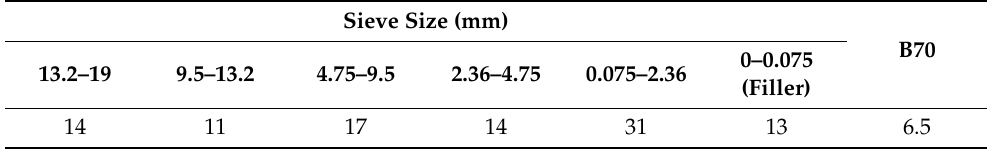
Table 1. Asphalt concrete mix (% of mineral